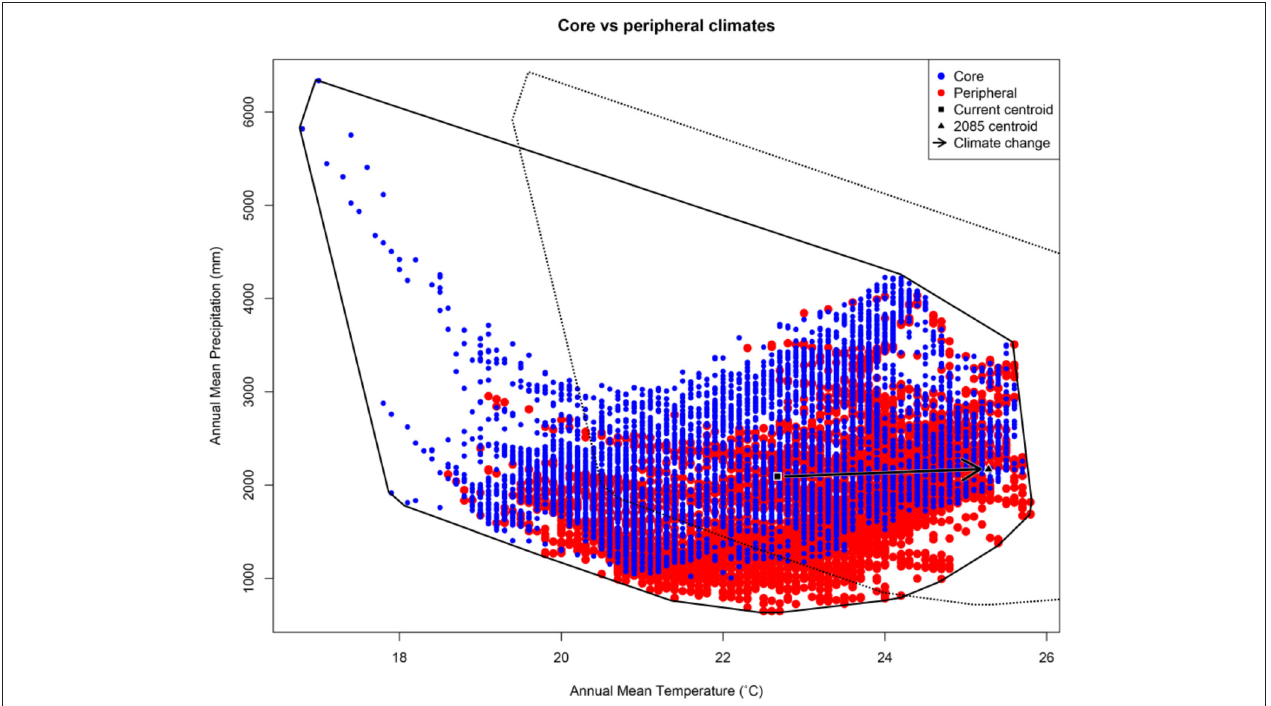
FIGURE 2 | Scatterplot showing spatial variation in two important axes of climate (annual mean temperature and annual mean precipitation) in Australia’s Wet Tropics (AWT). The vector shows the expected shift in the centroid of this climate envelope under climate change. Variation is shown for random points in each of 7,095 peripheral AWT rainforest patches (red); and, 7,095 random points in core AWT rainforest patches (blue). In the AWT, the only climate space not represented by peripheral patches is in the extreme wet-and-cool corner surrounding core patches (i.e., mountain tops in the AWT). Conversely, peripheral patches contain some climate spaces (particularly the warmer, drier climates) that are not represented in core patches. Polygons indicate the current climate envelope (solid line) and the future envelope (dashed line) produced by shifting the